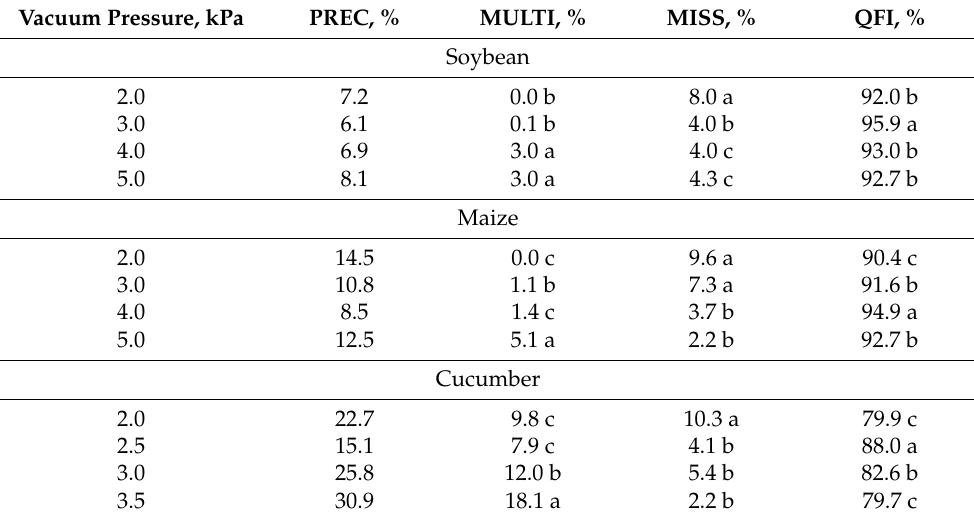
Table 2. Soybean, maize, and cucumber seeds metering uniformity of air-suction seed-metering device of precision seeder.